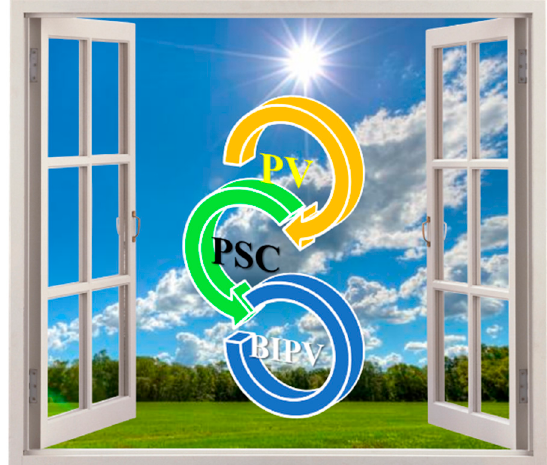
Figure 2. Schematic representation of the theme of this review represents perovskite solar cells integration to building-integrated photovoltaic (BIPV).